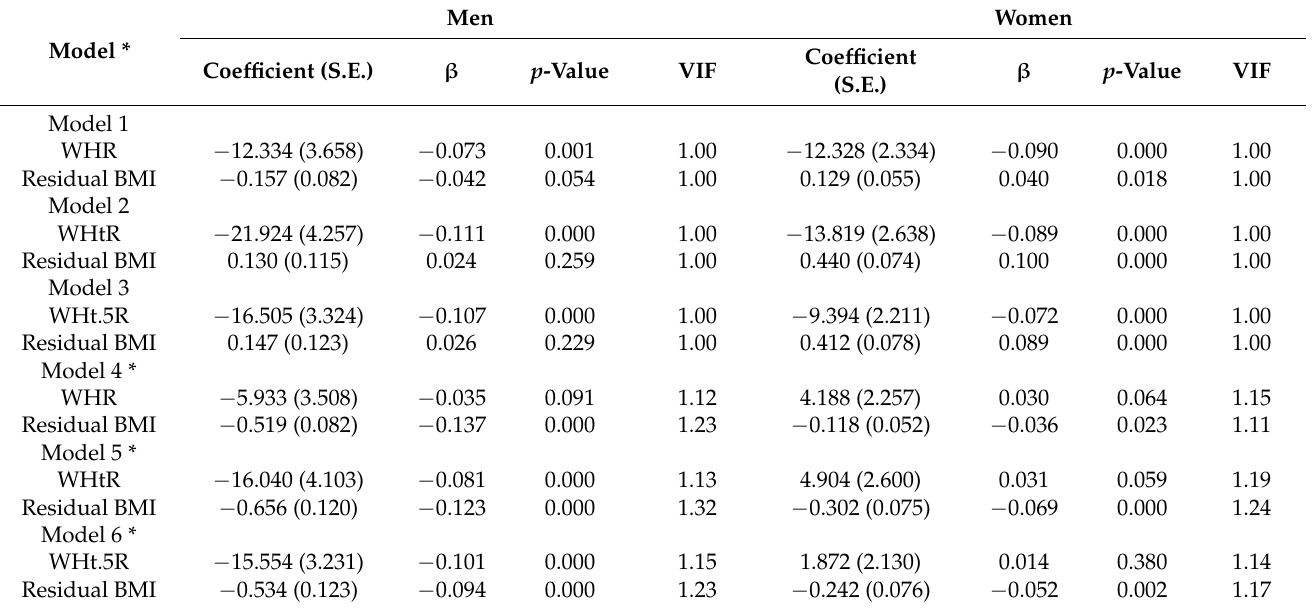
Table 3. Multiple linear regression of estimated glomerular filtration rates and waist circumference- related obesity metrics, compared with the residual body mass